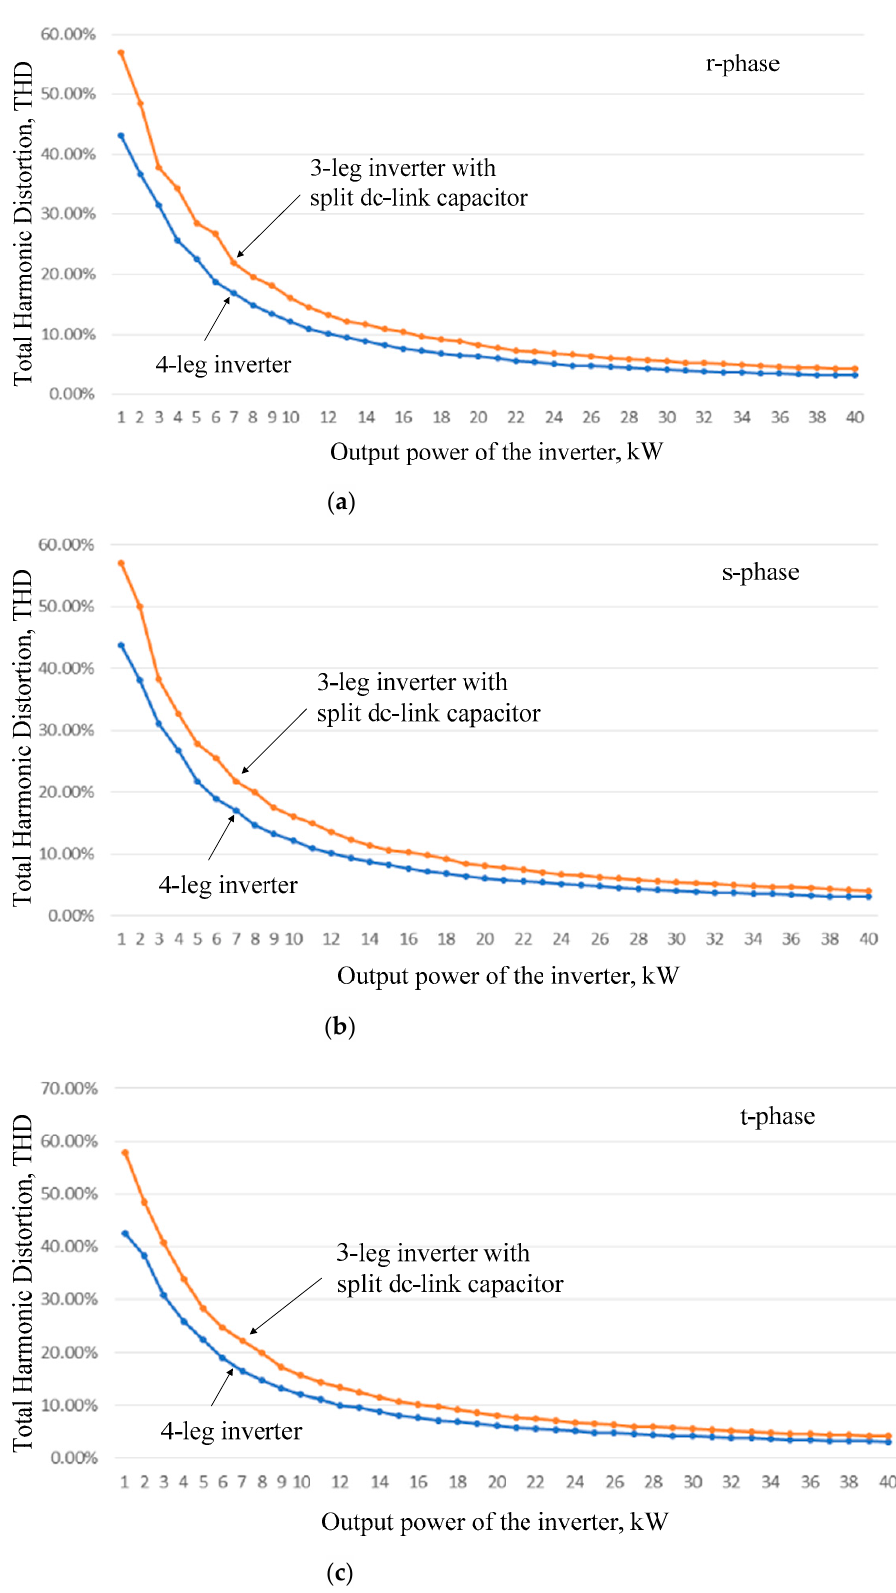
Figure 5. Comparison of total harmonic distortion (THD) of the phase current with the increase in the output power of the 3-phase 4-wire inverters: ( a ) r -phase; ( b ) s -phase; ( c ) t